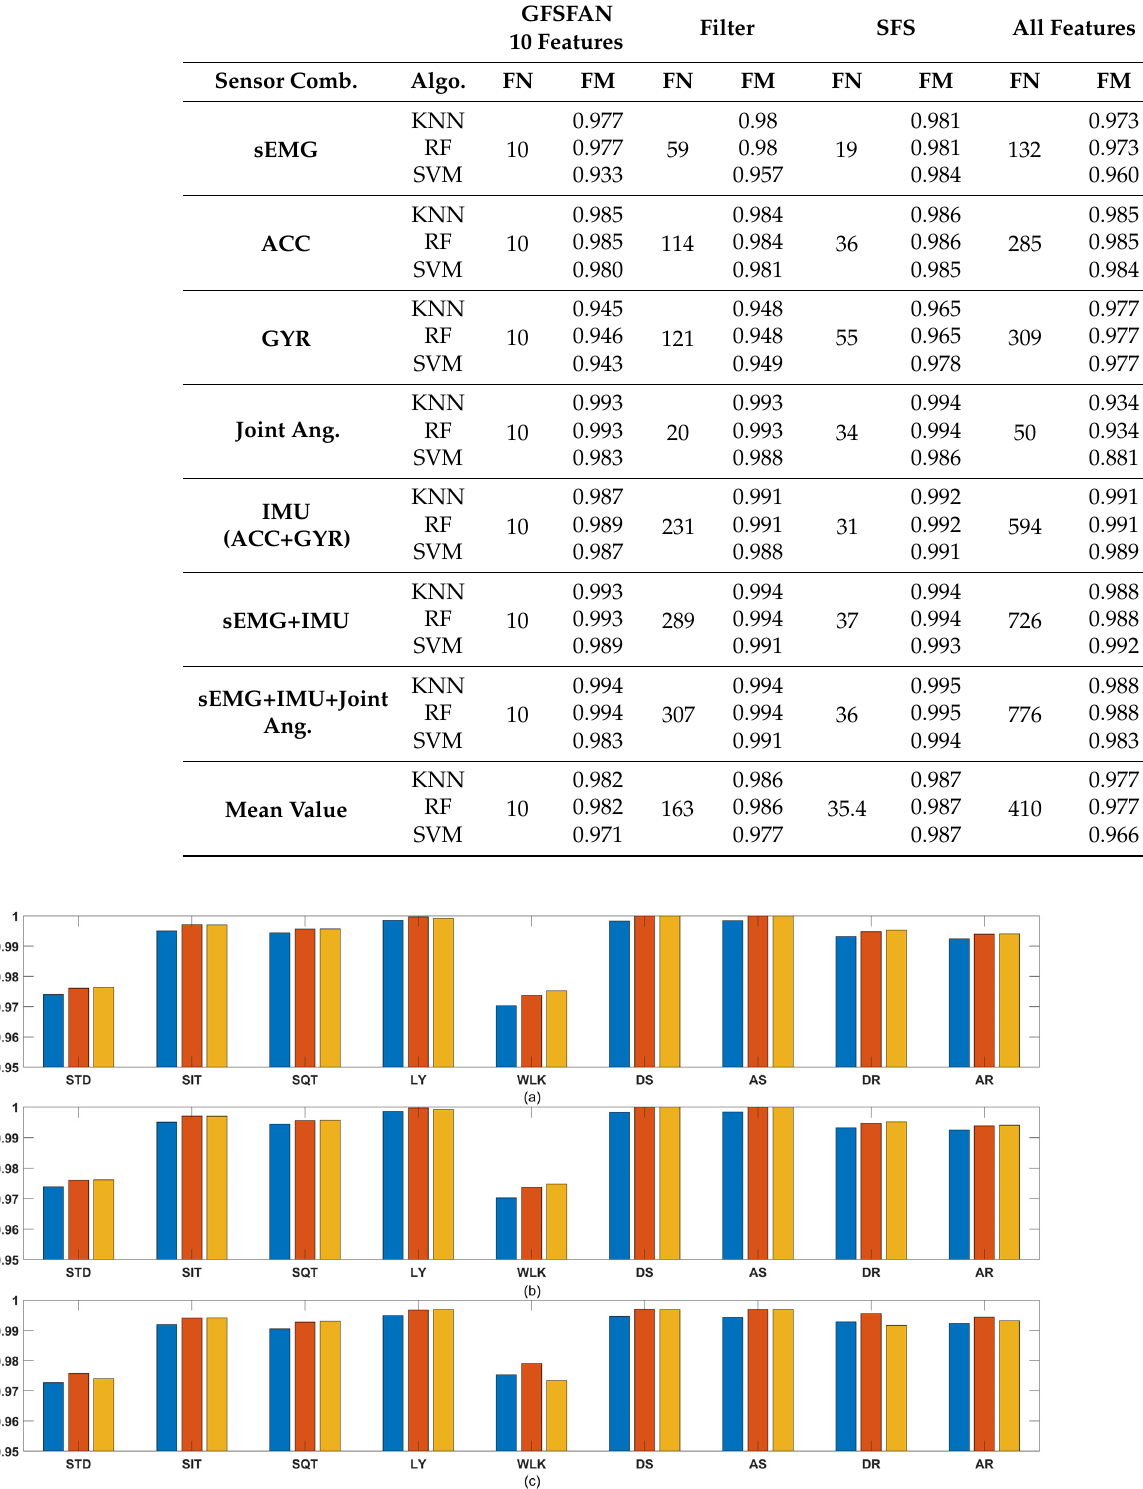
Table 4. The classification performance of different sensor combinations and different feature subsets with KNN, RF and SVM.